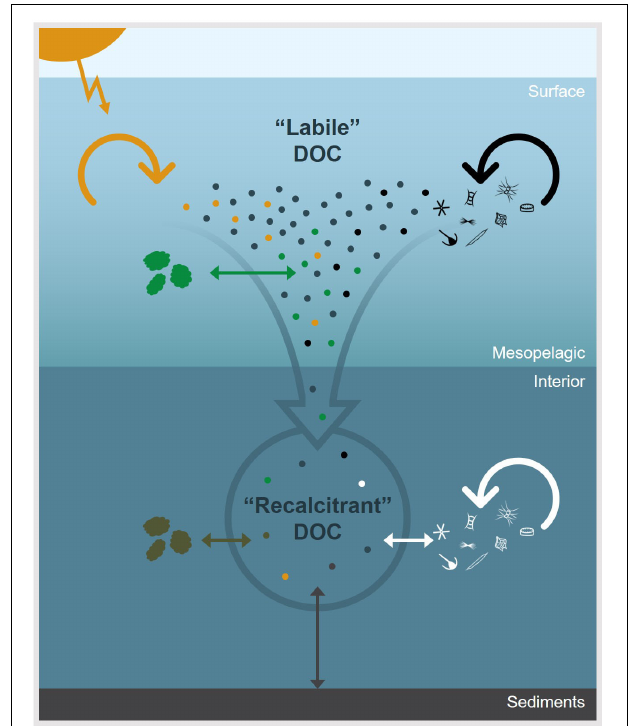
FIGURE 2 | A conceptual diagram of some of the major environmental processes which control the apparent recalcitrance of oceanic DOC. The dots represent DOC molecules and arrows represent physicochemical and biological processes that impact DOC concentration and molecular composition. In the surface ocean, DOC derived from primary production is rapidly remineralized or transformed through microbial degradation (black arrow), photochemical degradation (yellow arrow), or particle exchange (green arrow). Labile components are removed down the water column and DOC becomes diluted by processes, such as particle exchange (brown arrow), sediment dissolution (gray arrow), and microbial reworking (white arrow), which continue to alter, add, and/or remove molecules from the bulk DOC pool. Thus, the apparent recalcitrance of DOC in the ocean’s interior is an emergent property that is largely controlled by environmental